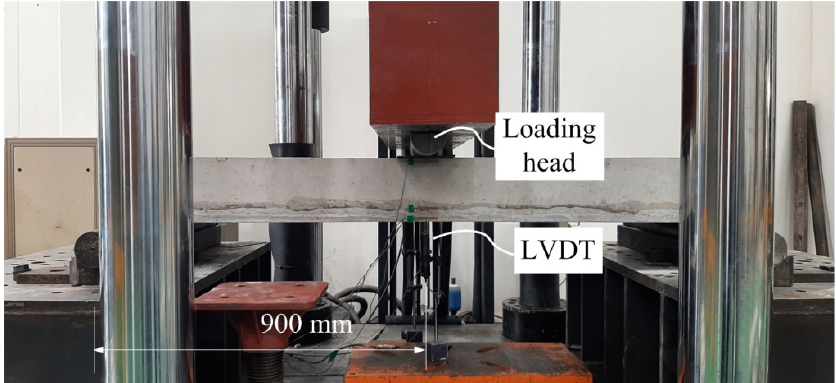
Figure 7. Flexural test setup and instrumentation.